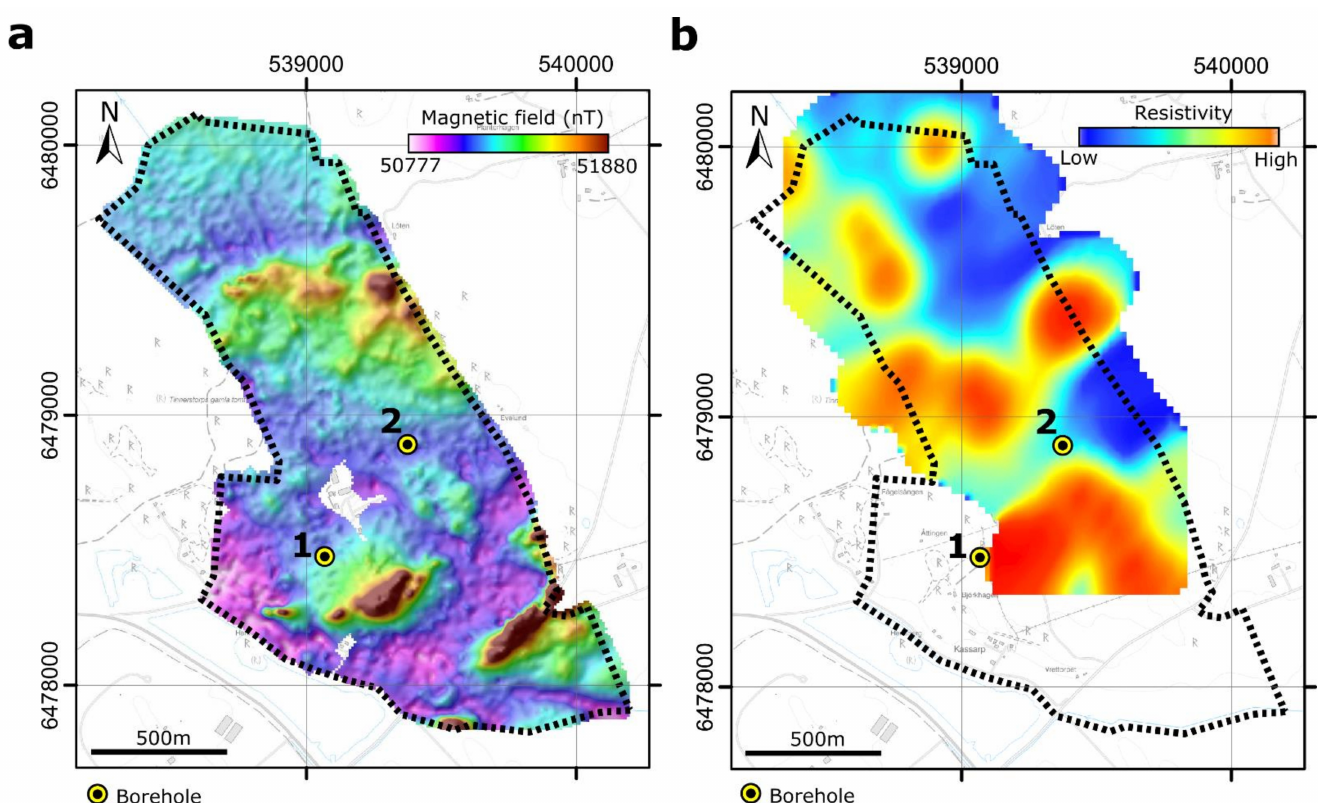
Figure 7. ( a ) A map of the total magnetic field over the study area. ( b ) Map of the average resistivity of the upper 300 m of the subsurface derived from the 3D resistivity model generated from VLF measurements. Borehole 1: Distorp Hagen, 2: Distorp